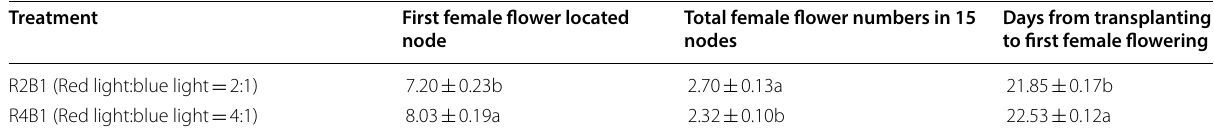
a,b: Statistically significant variations of mean values at different sampling points (ANOVA, p < 0.05) were indicated with different letters. Means denoted by the same letter did not differ significantly at p < 0.05